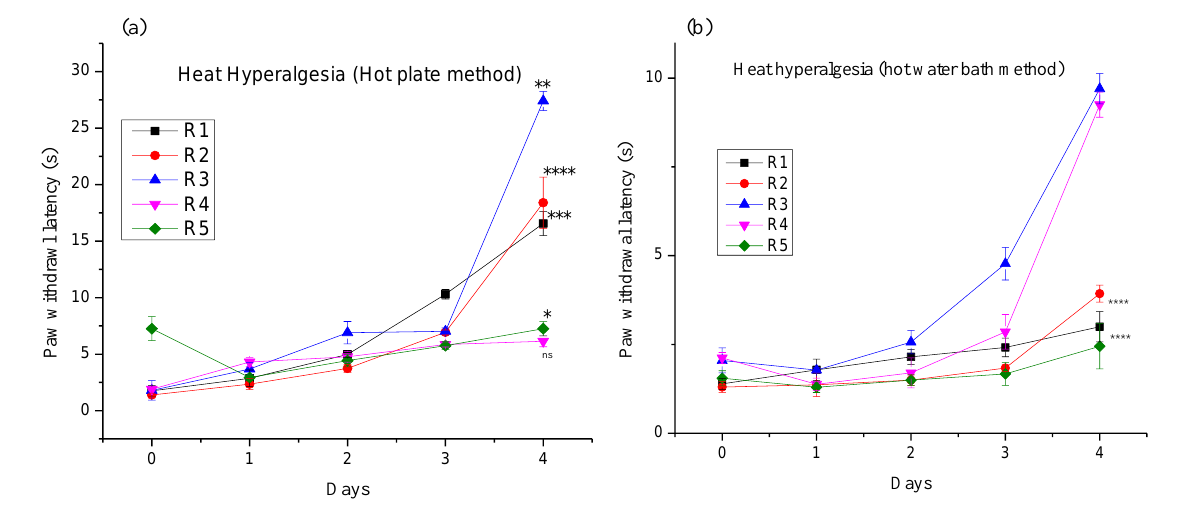
Figure 8. Heat hyperalgesia: ( a ) Hot plate and ( b ) hot water bath method. Where, *, **, ***, ****, ns represents very less significant, less significant, more significant, very much significant and non significant.